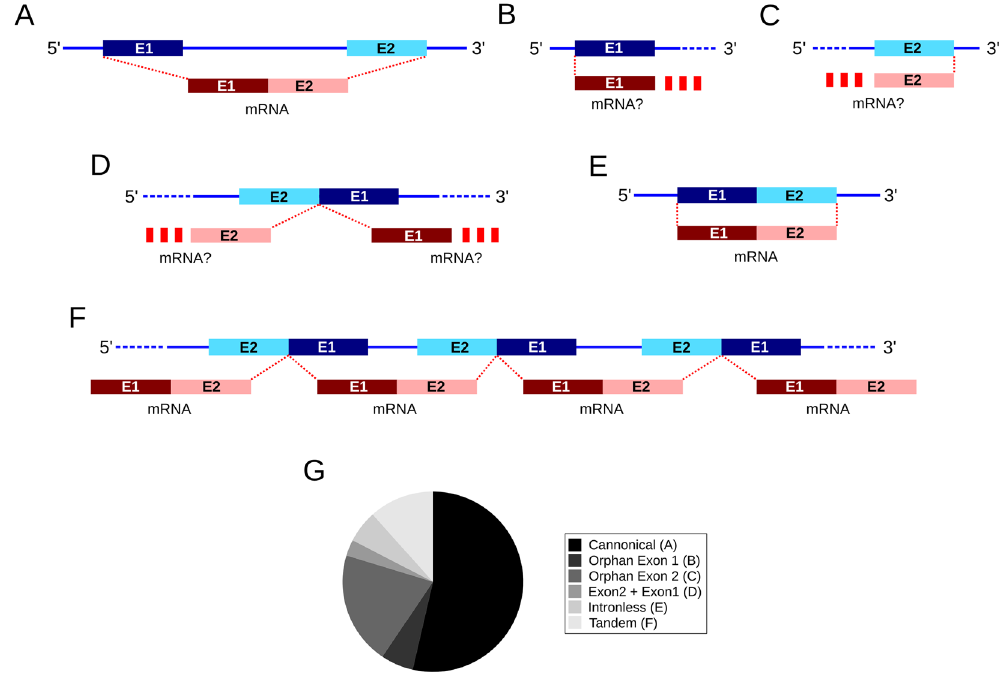
Figure 1. Schematic representation of each of the configurations shown by the CSPs’ exons in the different loci of L . migratoria ’s draft genome version 2.4.1 ( A – F ). ( G ) Sector graph showing the relative prevalence of each of the configurations in ( A – F